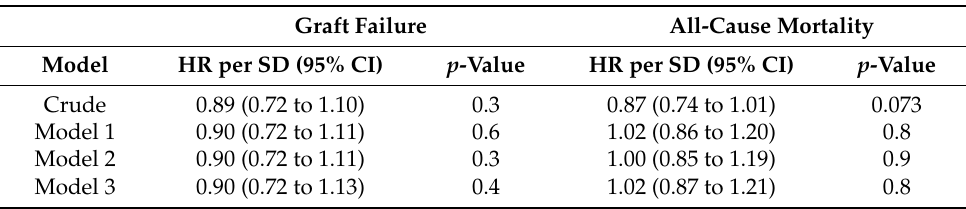
Table 2. Univariable and adjusted Cox regression analyses of the associations of plasma thallium with graft failure and